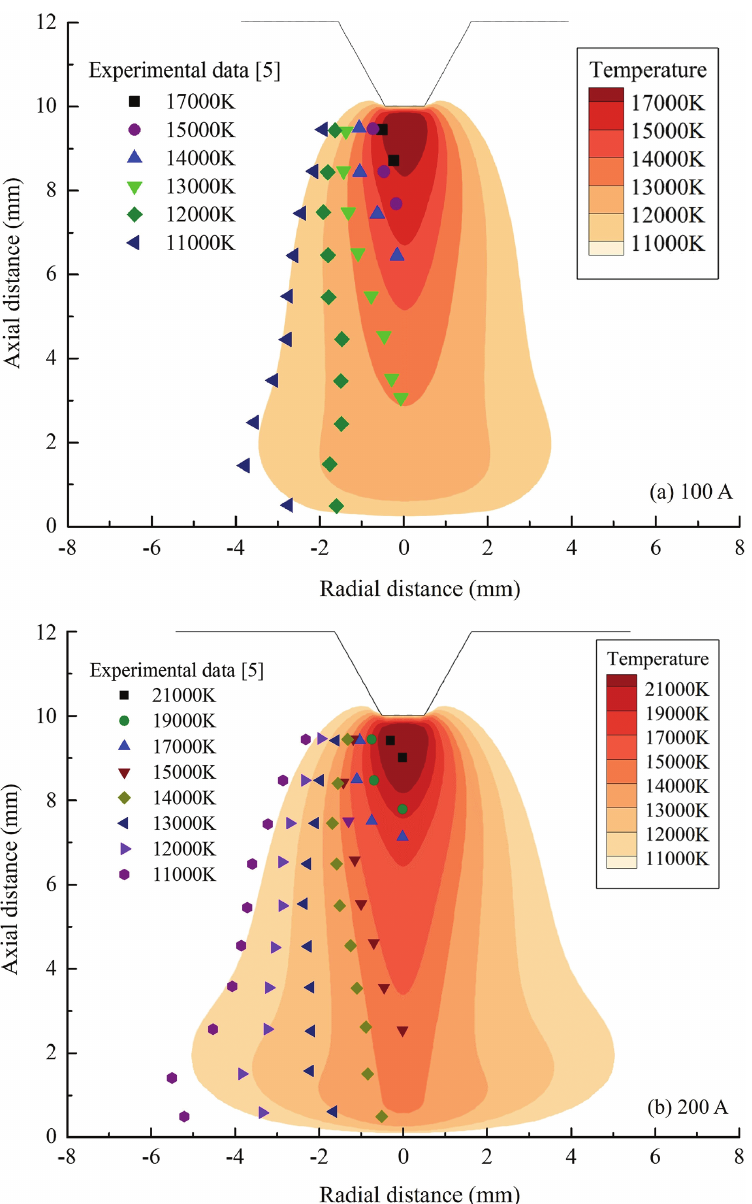
Figure 4: Calculated temperature contours in comparison with the experimental data [5]